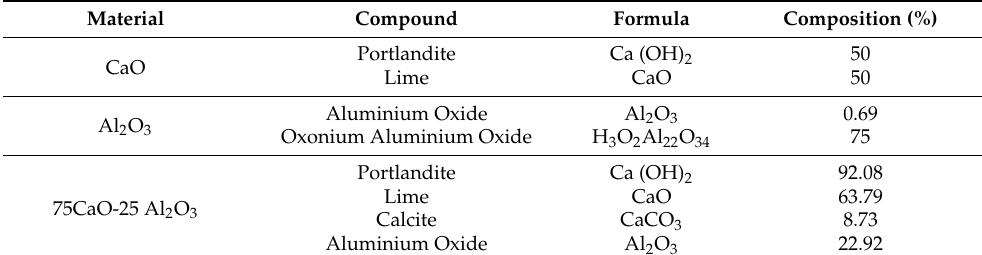
Table 1. Composition of compounds within the catalyst.